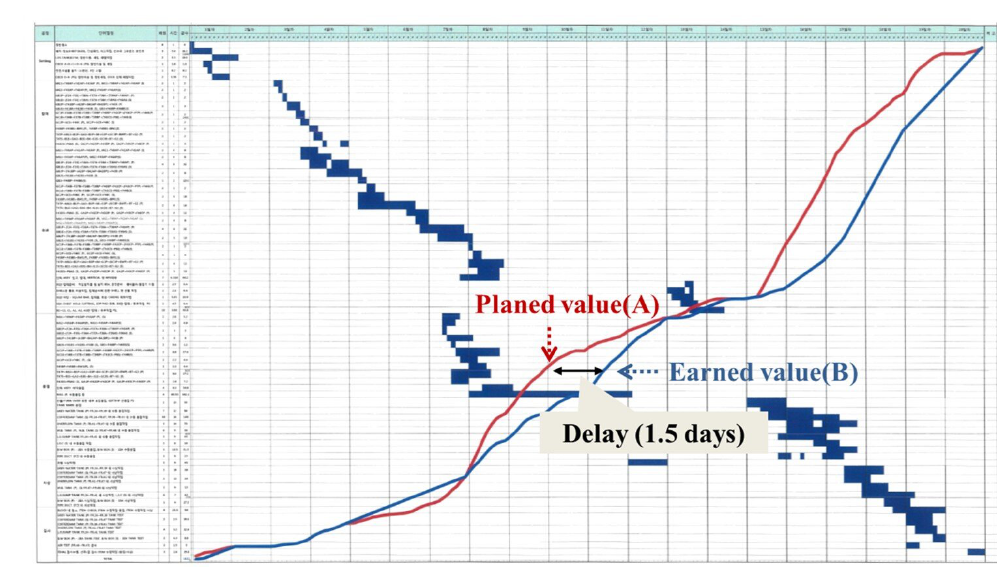
Figure 18. Graph of schedule variance.